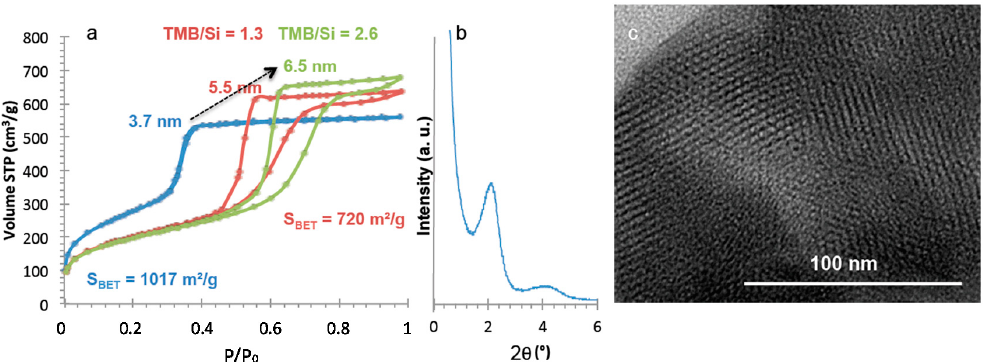
Figure 9. ( a ) Nitrogen sorption isotherms of calcined MCM-41-like hierarchical monoliths prepared with and without TMB (1,3,5-trimethylbenzene) as swelling agent; ( b ) XRD pattern; and ( c ) TEM picture of MCM-41-like hierarchical monolith prepared without TMB as swelling agent.